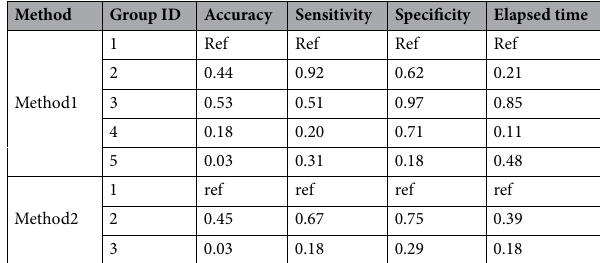
Table 3. P of Logistic GEE results of each group and each